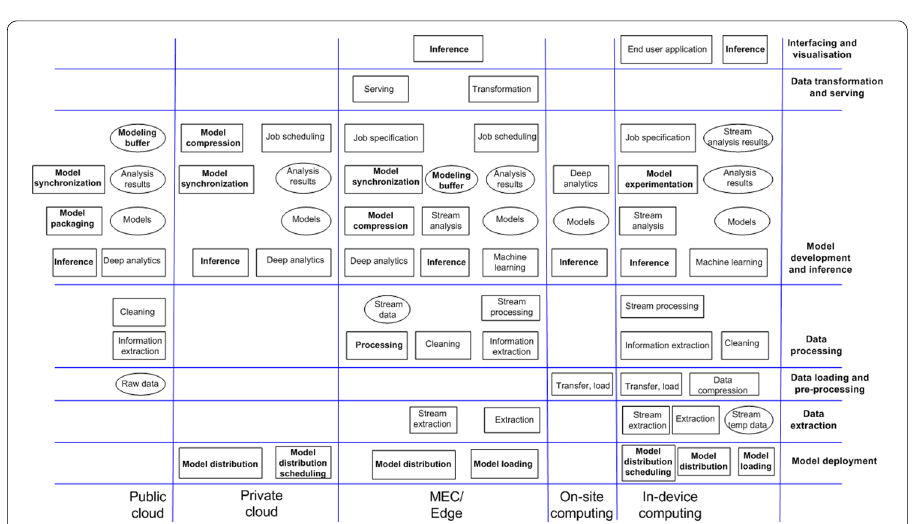
Fig. 4 Deployment environment view of the big data RA. Edge deployment environments are presented on the horizontal axis, and FAs of the high level view of the big data RA are provided on the vertical